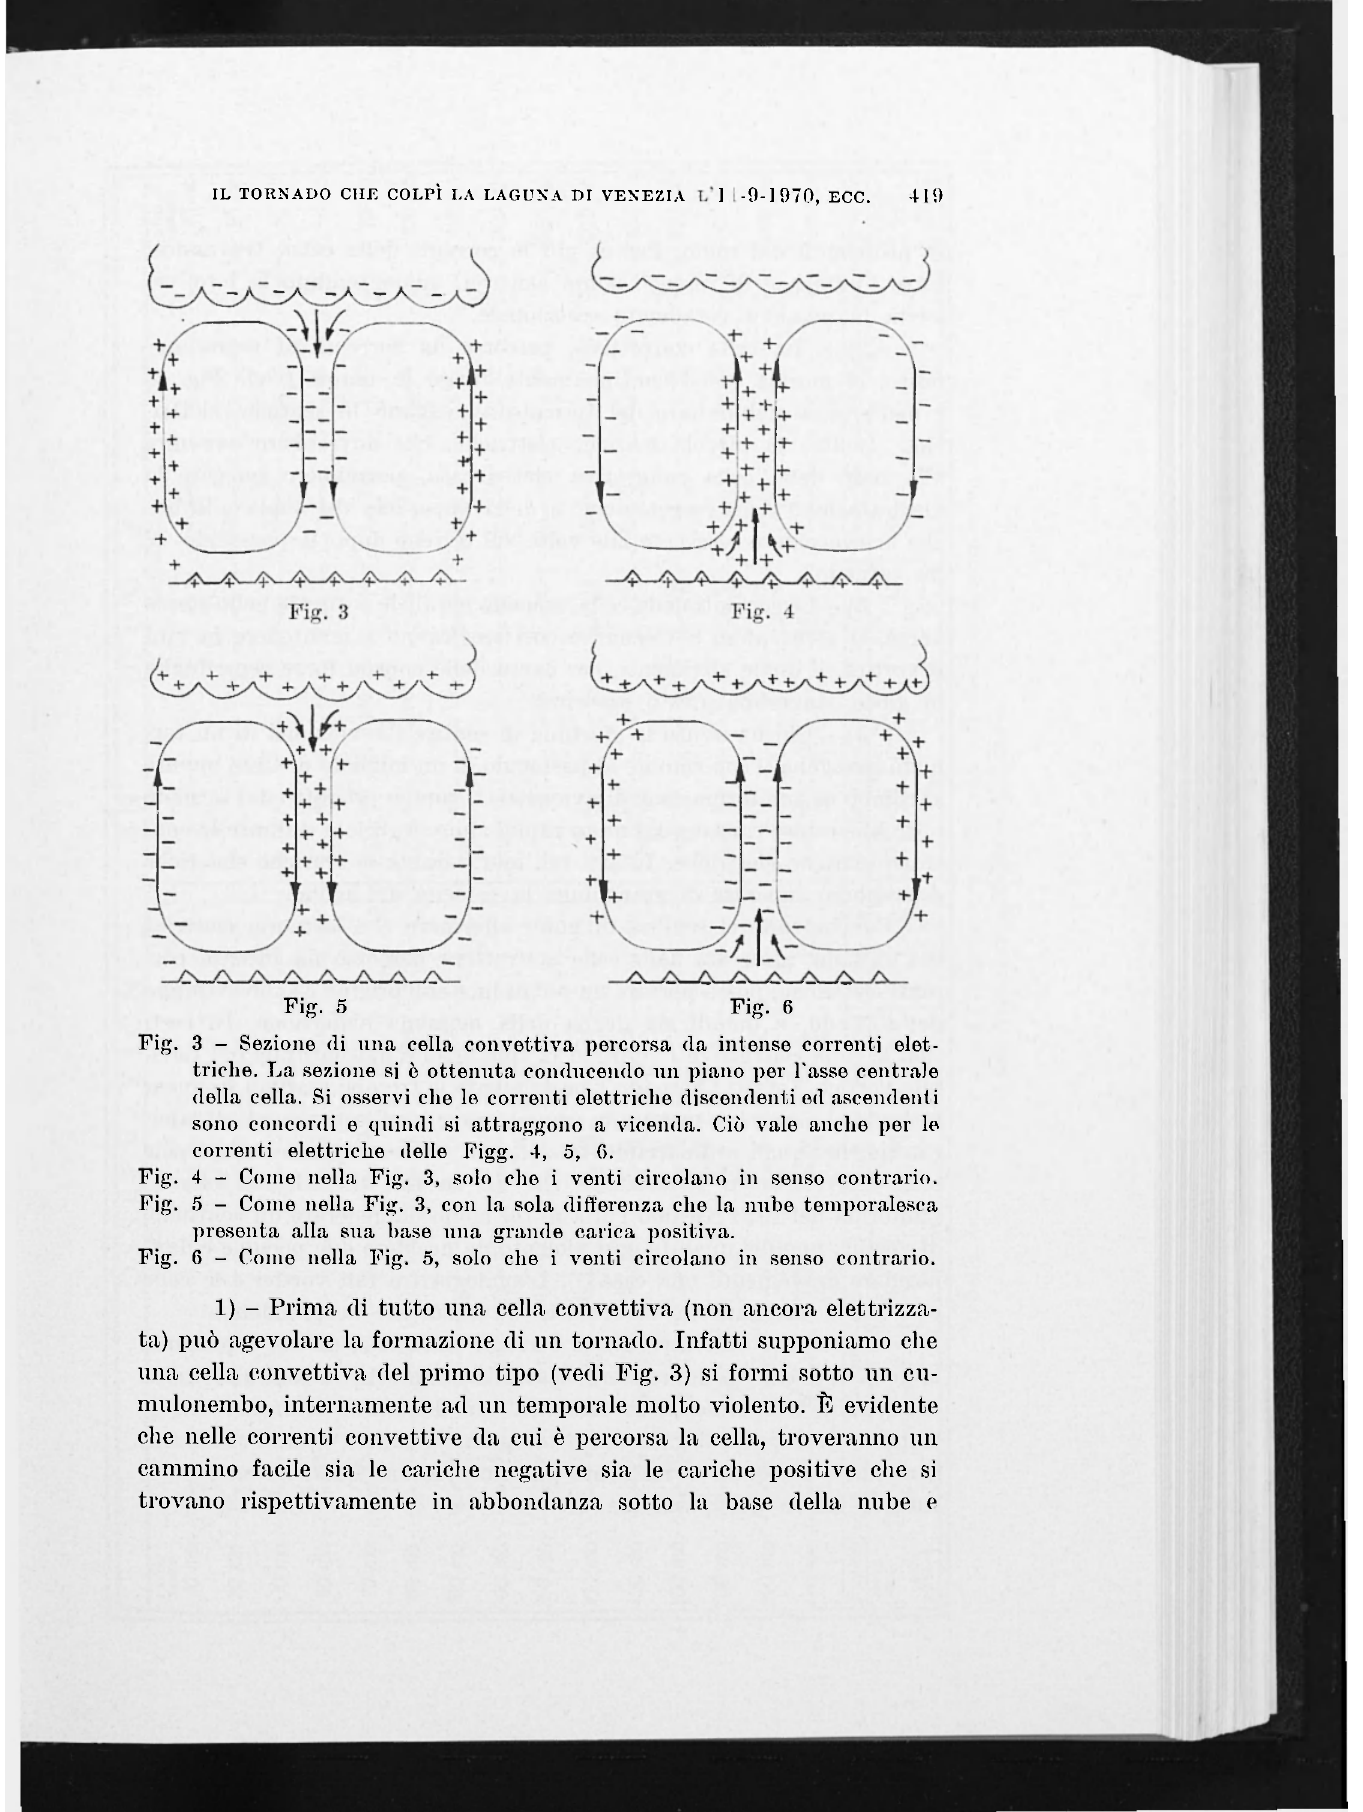
Fig. 3 - Sezione di una cella convettiva percorsa da intense correnti elet- triche. La sezione si è ottenuta conducendo un piano per l'asse centrale della cella. Si osservi che le correnti elettriche discendenti ed ascendenti sono concordi e quindi si attraggono a vicenda. Ciò vale anche per le correnti elettriche delle Figg. 4, 5,